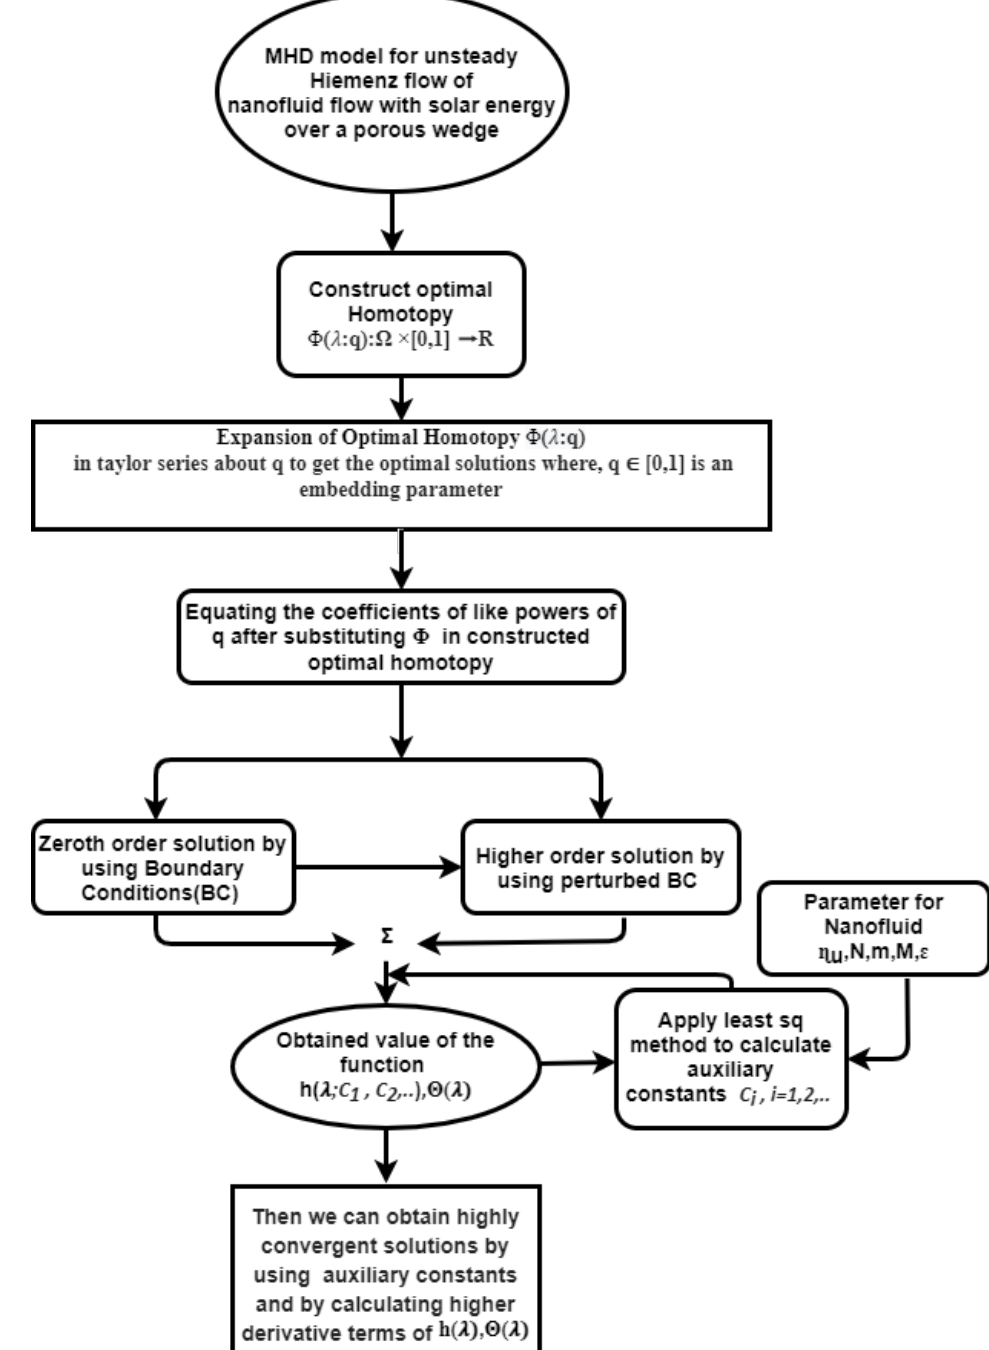
Figure 2. Schematic representation for the MHD Hiemenz flow analysis of nanofluid over a porous